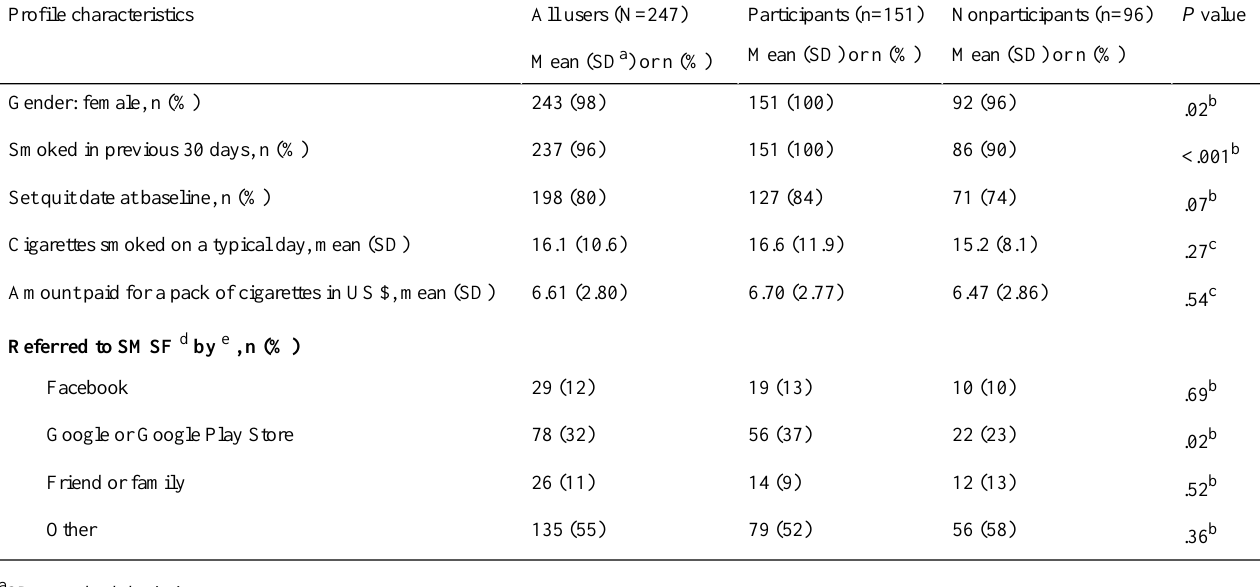
Table 1. Baseline characteristics from registration profile responses for all users who completed a profile; study participants and nonparticipants. Test results are for null hypotheses of no mean difference between participants and